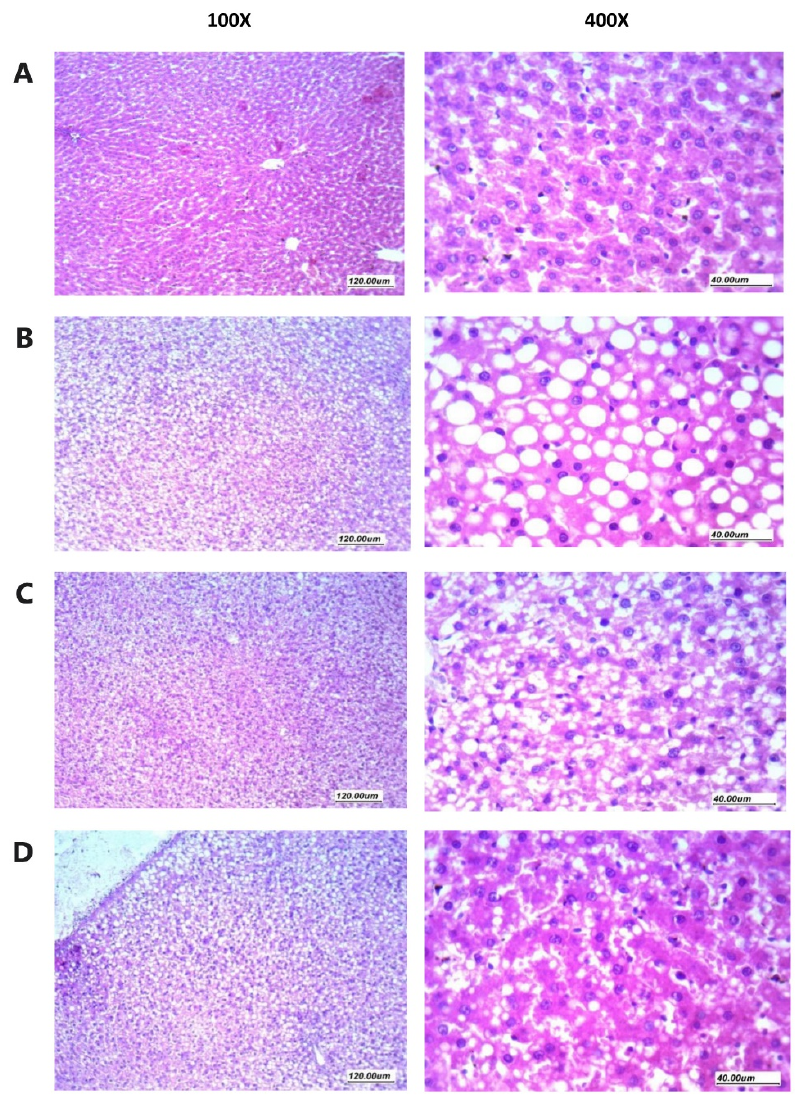
Figure 5. Histopathology of rat liver specimens stained with hematoxylin and eosin. ( A ) Sections from normal liver tissues showing preserved architecture, hepatocytes arranged in thin plates separated by patent sinusoids. Hepatocytes have having homogenous eosinophilic cytoplasm, with regular nuclei. ( B ) Sections from liver tissues in NASH control group showing disturbed architecture, hepatocytes arranged in thick plates with marked steatosis (macro vesicular) presented as large cytoplasmic clear regular vacuole, with obscured sinusoids in-between. Nucleus is pushed to one side of the cells with regular or compressed contours. ( C ) Sections from liver tissues from NASH + hemp seed oil group showing moderately obscured sinusoids and predominantly preserved architecture, hepatocytes showing moderate steatosis (micro vesicular) with small to moderate-sized cytoplasmic clear vacuoles and regular vesicular nuclei. ( D ) Sections from liver tissues from the NASH + NEF#4 of hemp seed oil group showing predominantly preserved architecture, and patent sinusoids, hepatocytes arranged in thin plates, hepatocytes showing mild focal steatosis (micro vesicular) with a small number of scattered small-sized cytoplasmic clear vacuoles and regular vesicular nuclei.